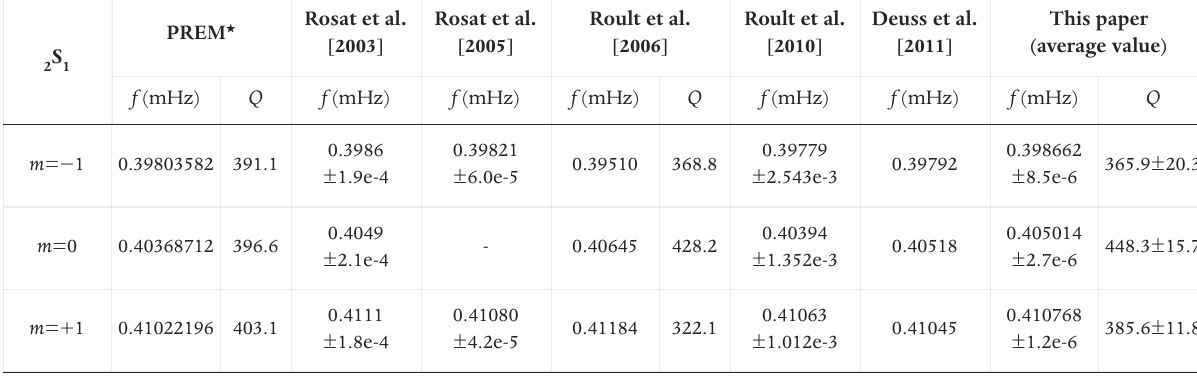
Table 4. The observed and predicted values of frequencies and Q s of